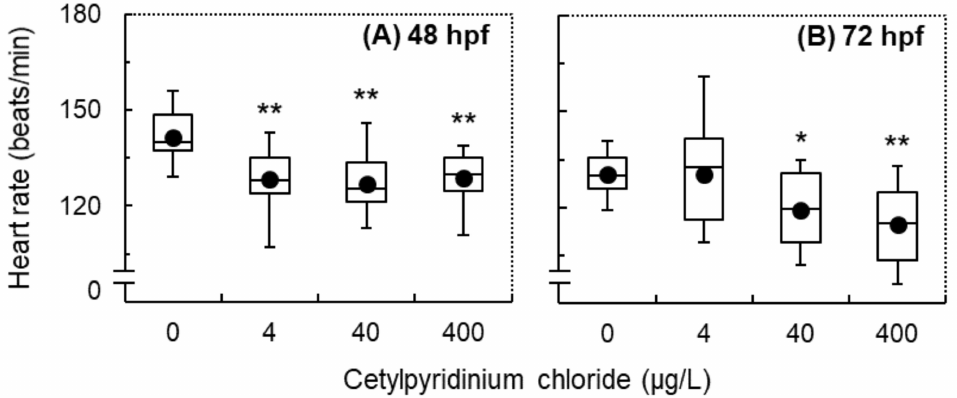
Figure 2. The heart rate of zebrafish (Danio rerio) exposed to cetylpyridinium chloride (CPC) at levels of 0 (control), 4.0, 40, and 400 µ g/L for 48 ( A ) and 72 ( B ) hours post-fertilization (hpf). Data are presented as means ± SE (n = 18). Asterisks denote statistically significant differences between the exposure and control groups (* p < 0.05; ** p <